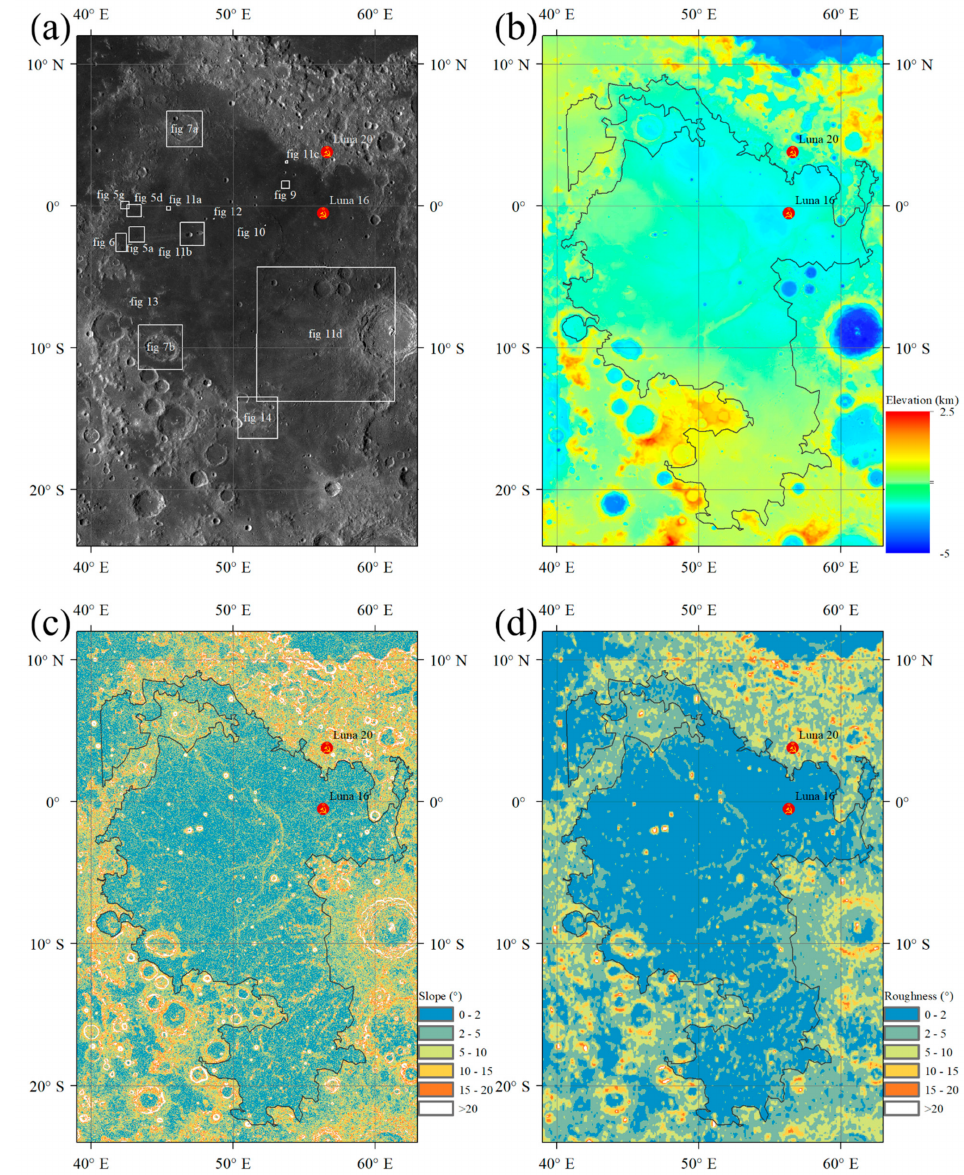
Figure 2. The ( a ) WAC image. The white boxes represent the locations of other figures in this paper ( b ) SLDEM2015, ( c ) SLDEM2015 slope, and ( d ) LOLA roughness of Mare